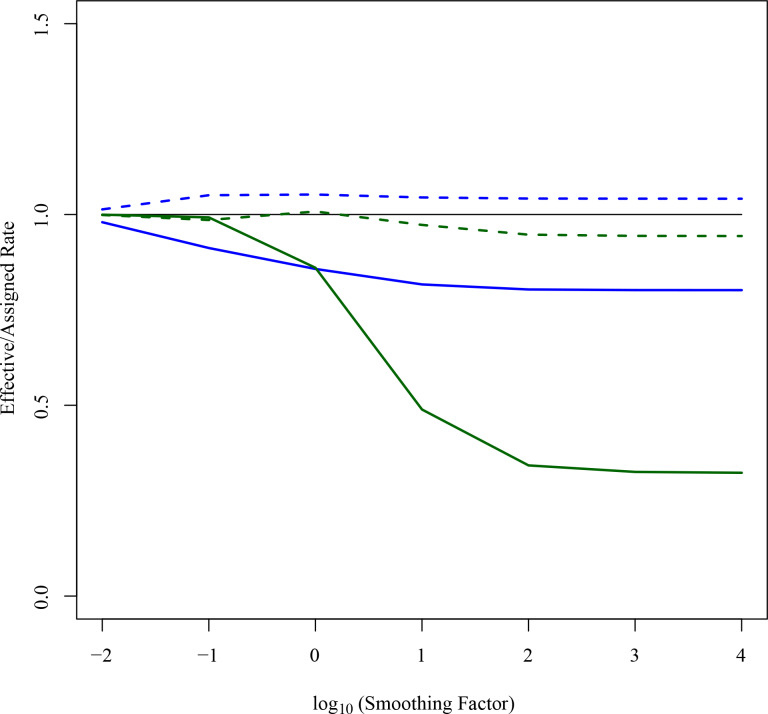
Rate assignment on crown and stem branches of Isoetes in r8s.The ratio of effective vs. assigned rates is shown for different smoothing factors in r8s for the stem branch of Isoetes (solid lines) and for the Isoetes crown branches (average; dashed lines), for the concatenated chloroplast (green) and nuclear (blue) datasets. Solid black line represents effective/assigned rate ratio of 1, for reference.